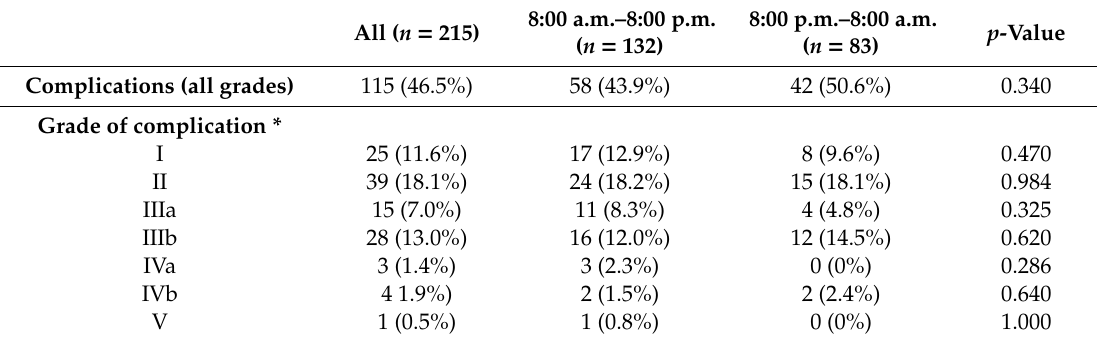
Table 3. Postoperative complications with Clavien–Dindo Classification. Results are presented as absolute and relative frequencies. * If more than one occurred per case, according to patient records, the complication